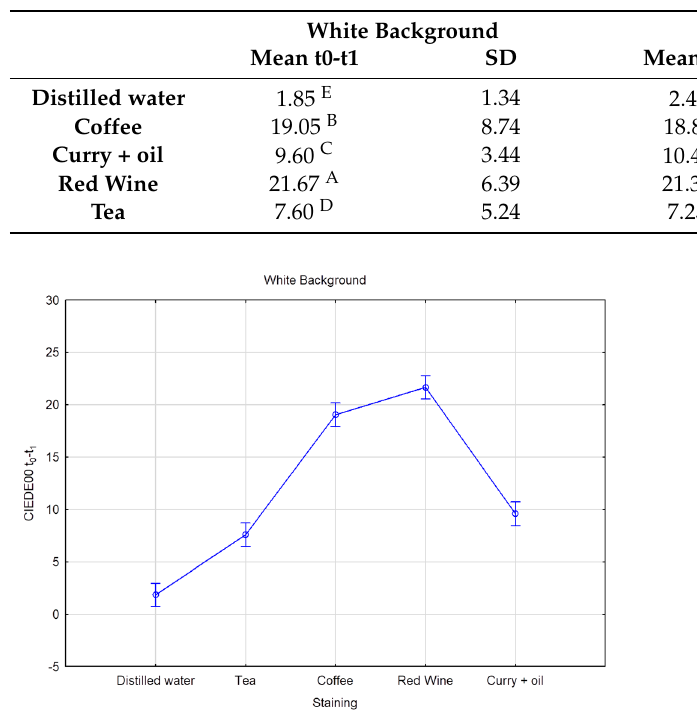
Figure 2. Average color difference in terms of CIEDE00 over time according to different staining liquids analyzed over a black background. Vertical bars denote 95% confidence intervals. Table 8. Mean and Standard Deviations of CIEDE00 color differences (t0-t1) according to different staining liquids analyzed over a white and a black background. ABCDE rankings are from the highest ( A ) to the lowest staining results using Fisher’s LSD post hoc test at a p -value < 0.01.